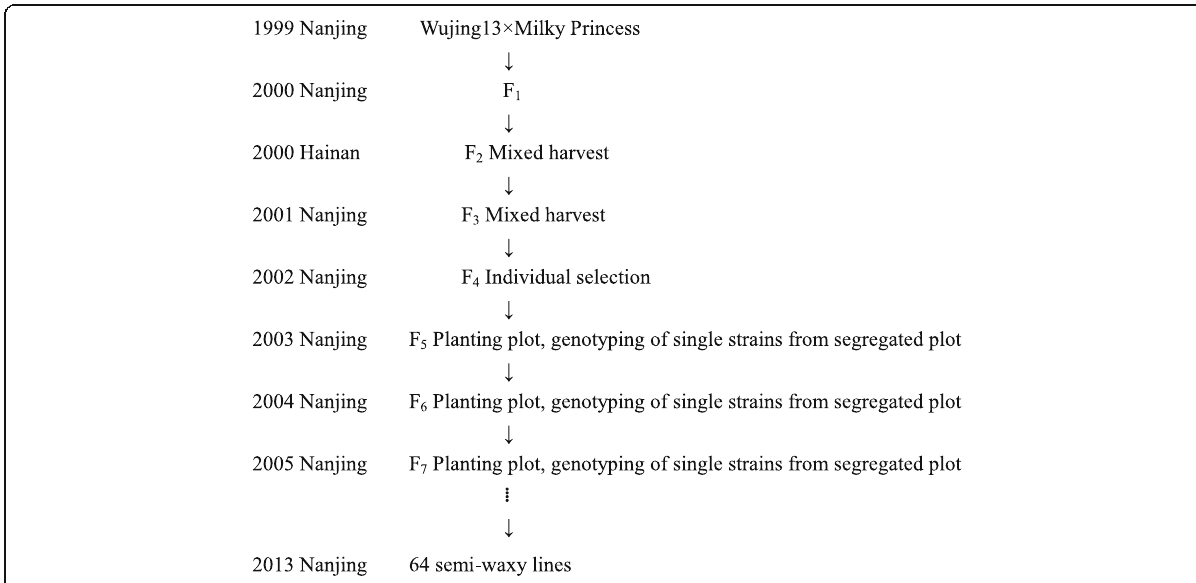
Fig. 1 Development of 64 semi-waxy lines derived from Wujing 13/Milky